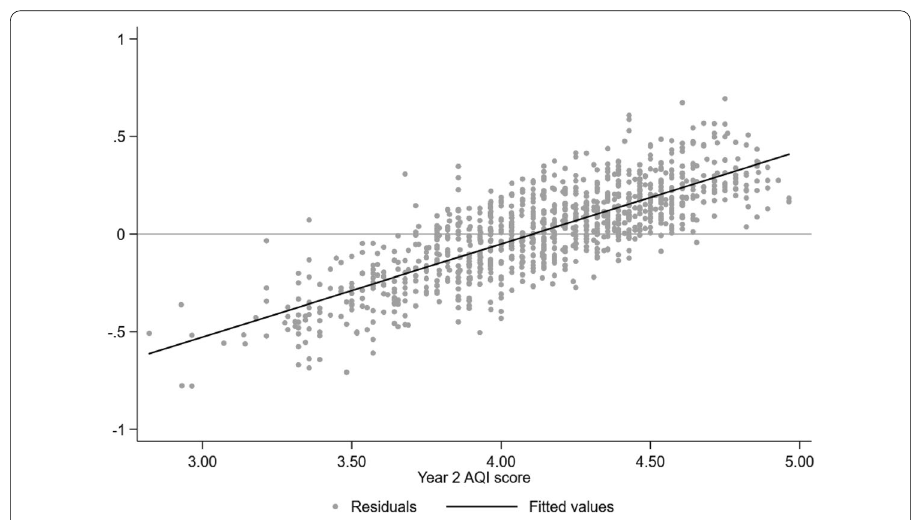
Fig. 2 Distribution of residuals against year 2 fitted values